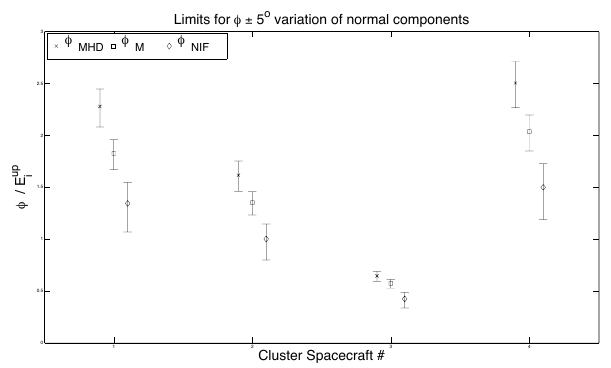
Fig. 5. Electric cross-shock potential estimates of all four Clus- ter spacecraft. The circle markers represent the potential estimates prior to any variation whereas, the error bars represent the upper and lower limits of the maximum and minimum potential evaluations as a result of a variation about the model normal of ± 5 ◦